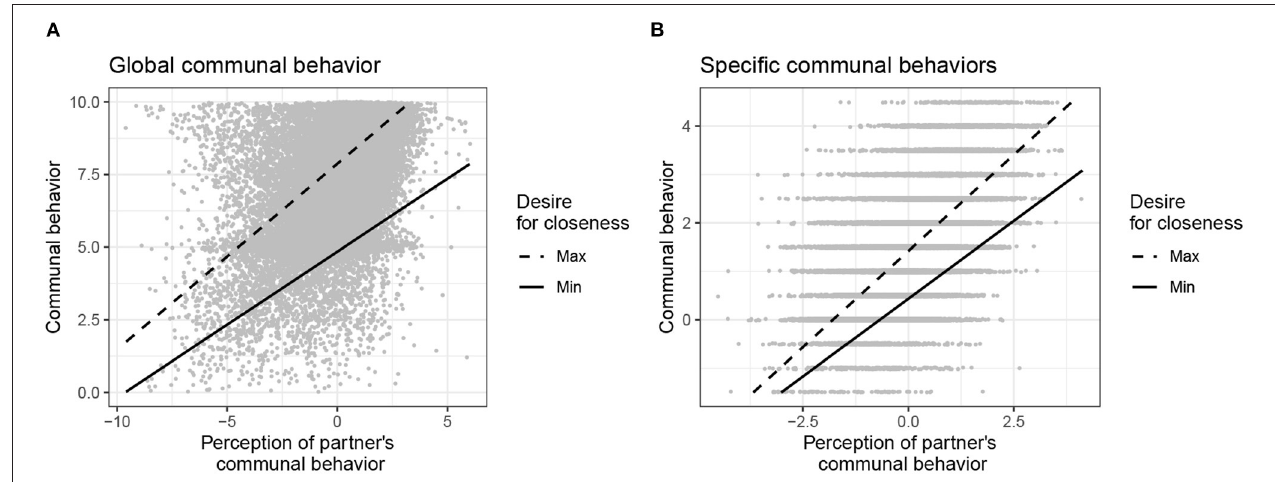
FIGURE 2 | Prediction of communal behavior by the cross-level interaction between individuals’ desire for closeness and their perceptions of their partners’ communal behavior. (A) Global communal behavior. (B) Specific communal behaviors. Figure available at: https://osf.io/2fz5w/ under a CC-BY4.0